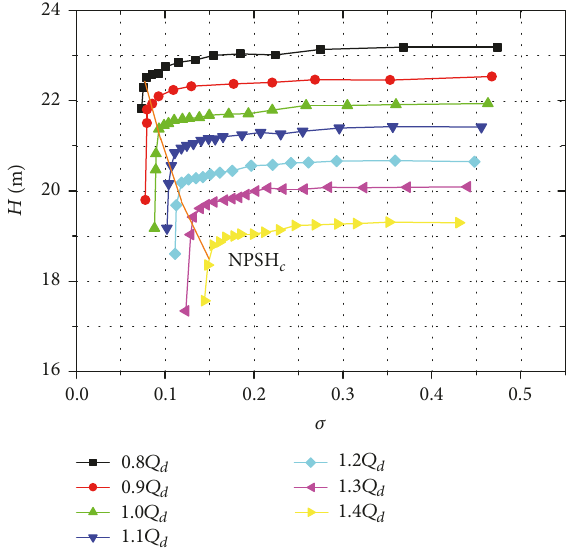
Figure 6: Cavitation performances at different flow